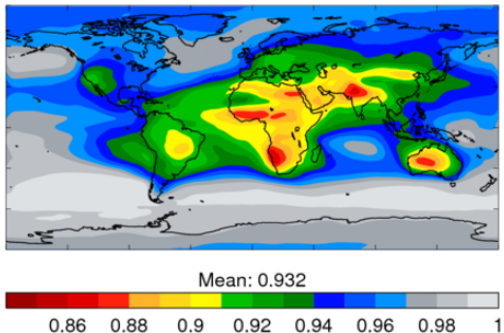
Figure 5. Annually averaged distribution of column-averaged single-scattering albedo at 0.55µm used to characterise absorption of anthropogenic